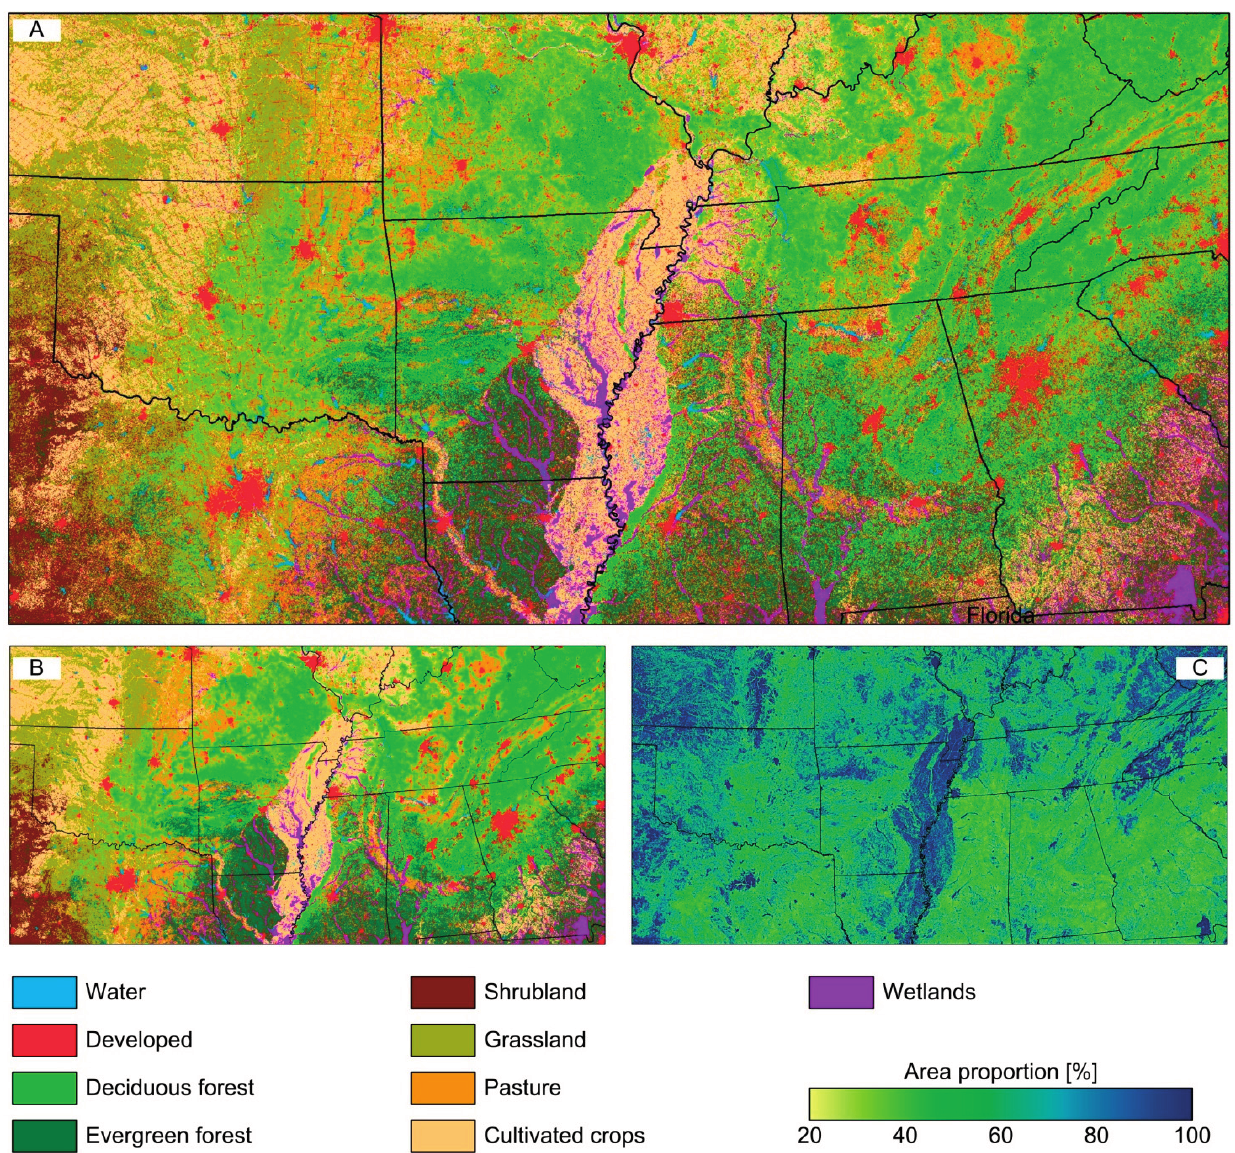
Figure 3. ( A ) Reference map at 30m spatial resolution; ( B ) coarsened map at 900 m using majority rule, argmax(H) ; and ( C ) area proportion of that class, max(H)